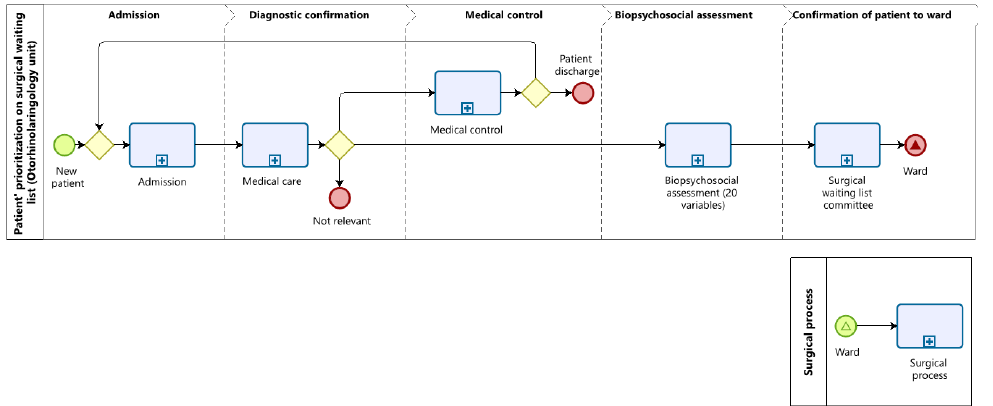
Figure 2. SWL prioritization process, according to